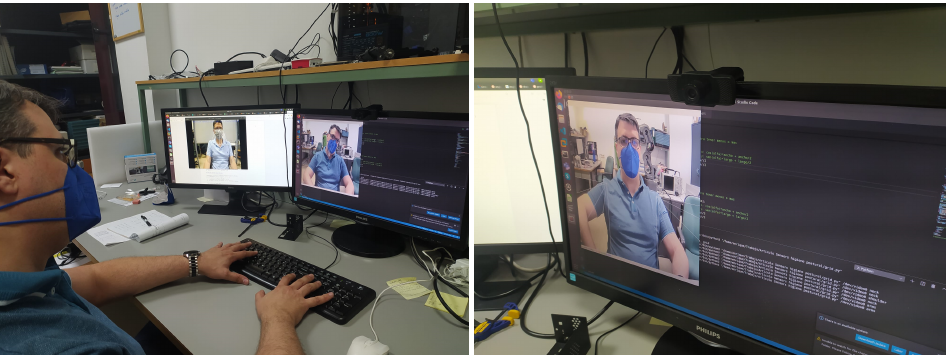
Figure 2. Setup with the webcam on the screen